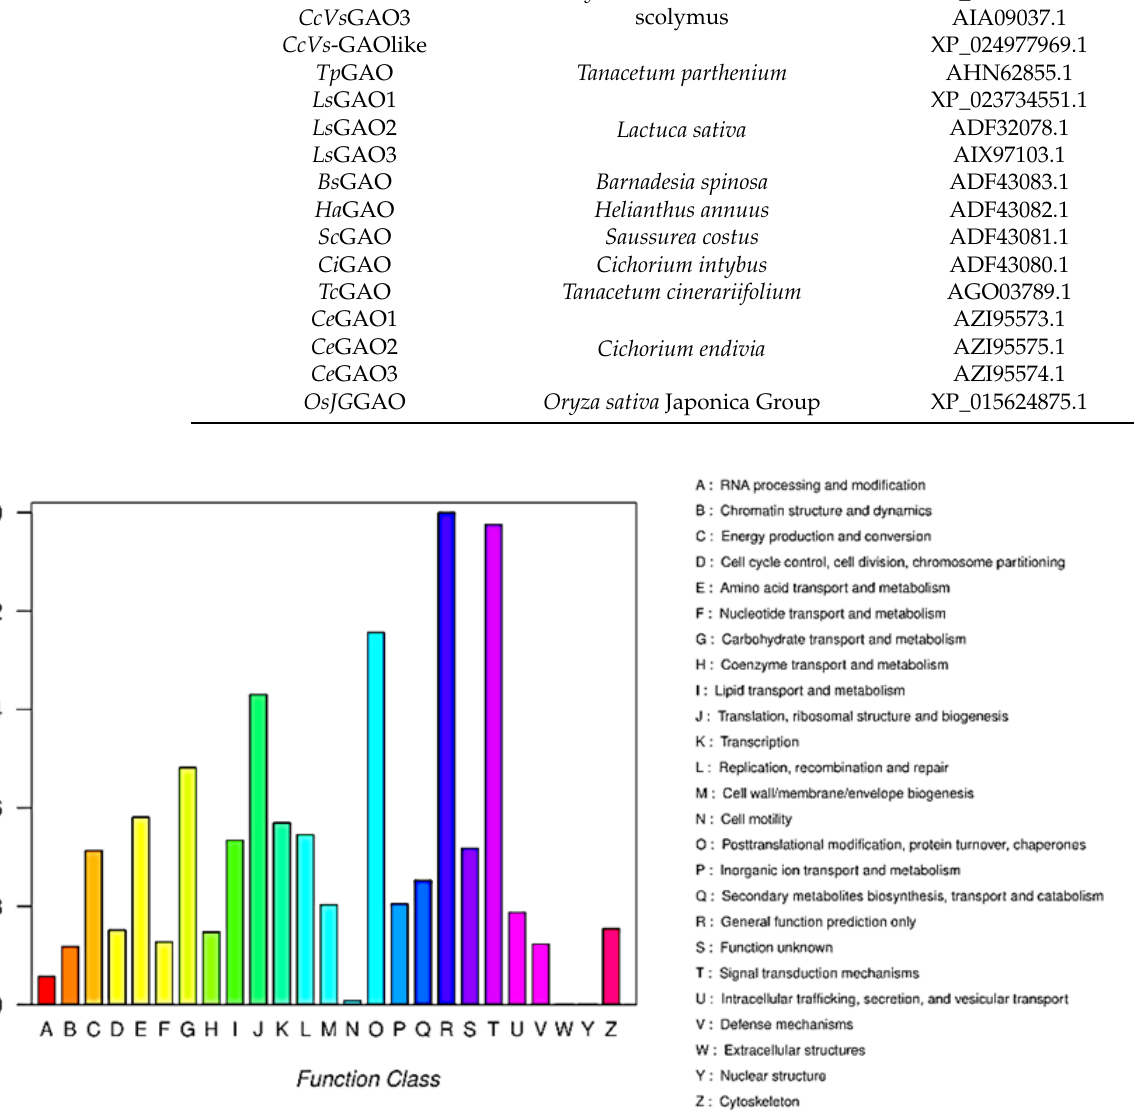
Figure A1. COG classification of X. sibiricum unigenes.